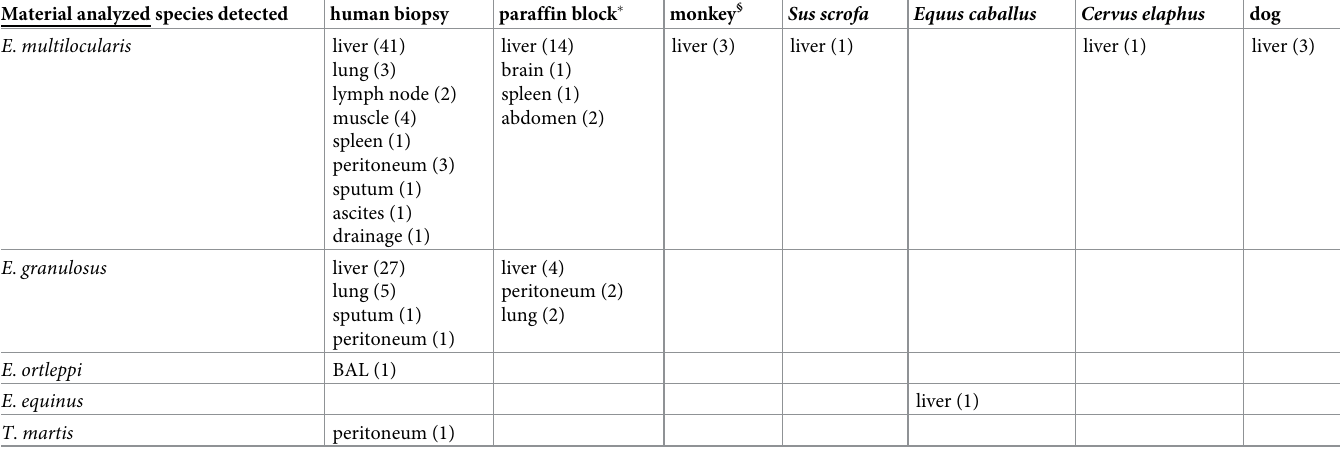
Table 3. PCR positive diagnosis of different Echinococcus species in human and animal biopsy material. Material analyzed species